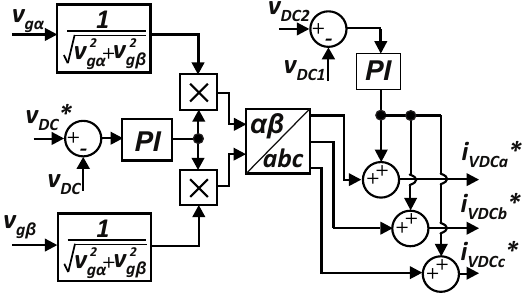
Figure 8. DC-link regulation